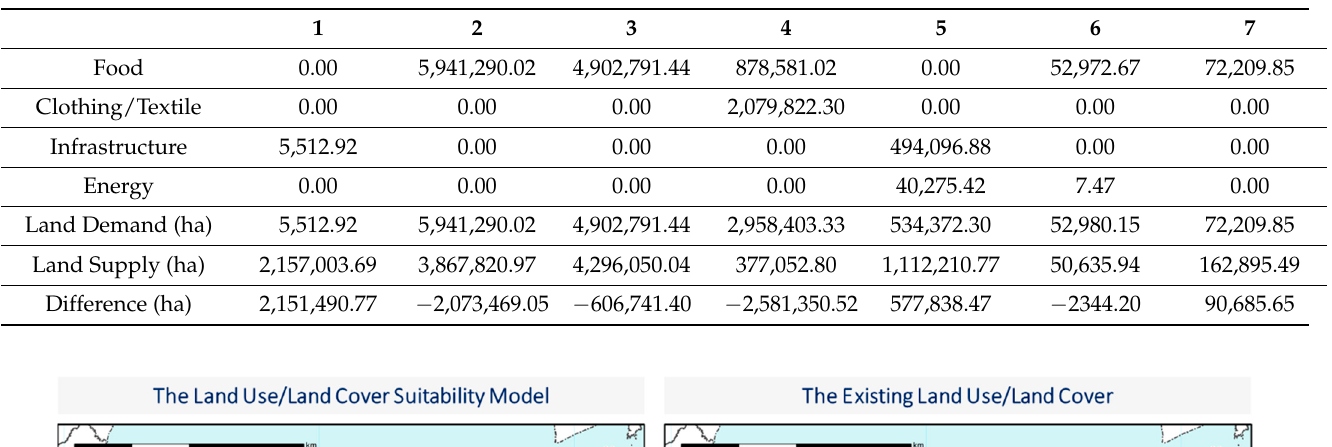
Table 8. Spatial allocation (ha) based on physiological needs and the fulfillment in Java Island: (1) forest, (2) wetland agriculture, (3) dryland agriculture, (4) plantation, (5) built-up land, (6) pastureland, and (7) inland fishing grounds.